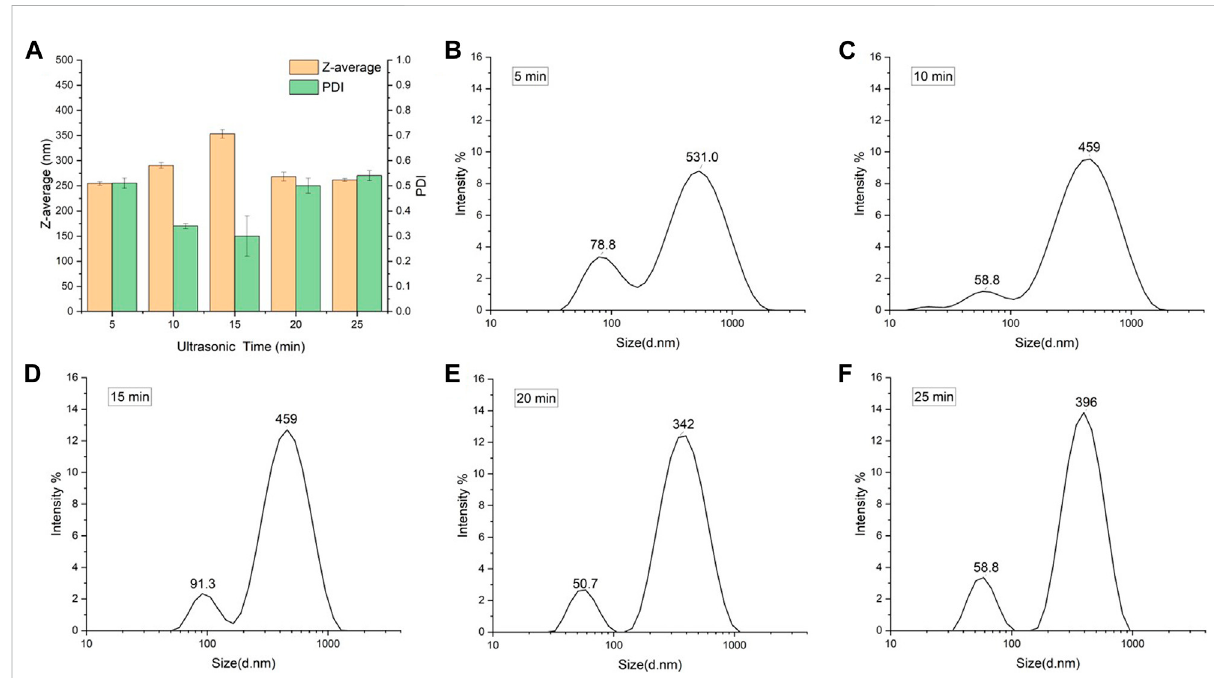
FIGURE 2 Particle size of freeze-dried SNPs prepared by different ultrasonic time. (A) Z-average and PDI. Size distribution of SNPs prepared by ultra- soni fi cation for 5 min (B) , 10 min (C) , 15 min (D) , 20 min (E) , and 25 min (F)